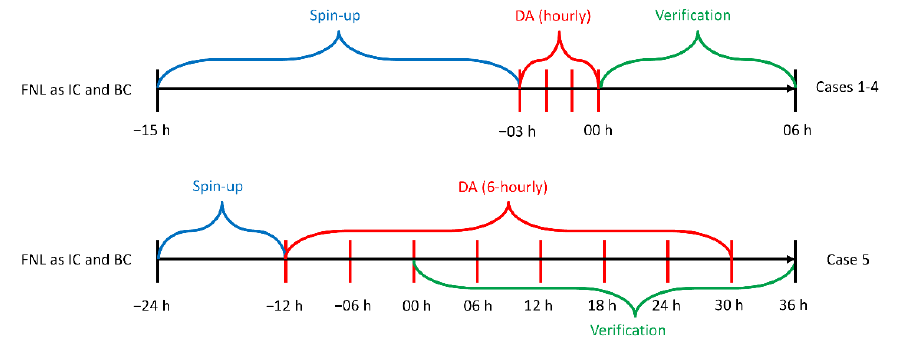
Figure 3. Illustrations of the experiments in different cases.